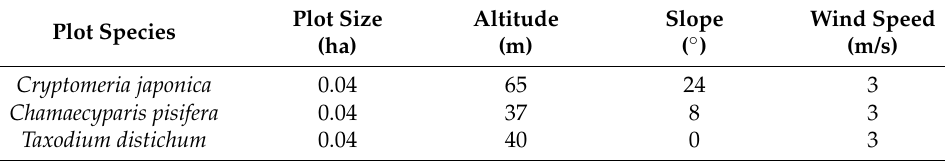
Table 1. Geographical characteristics of each plot in the study area. Plot Size Altitude Slope Wind Speed Plot Species (ha) (m) ( ◦ ) (m/s) Cryptomeria japonica 0.04 65 24 3 Chamaecyparis pisifera 0.04 37 8 3 Taxodium distichum 0.04 40 0 3